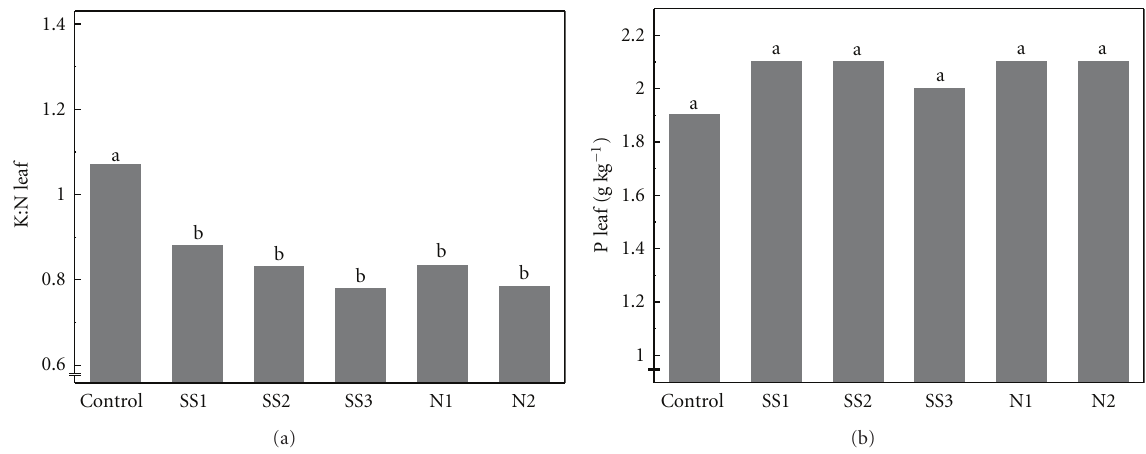
Figure 3: Potassium/nitrogen ratio (K:N) (a) and P concentration in banana index leaves (b) from plots treated with biosolids (SS) and mineral N fertilizer (N). Columns followed by the same letters indicate that values do not di ff er by the Student’s t -test ( P > . 05).